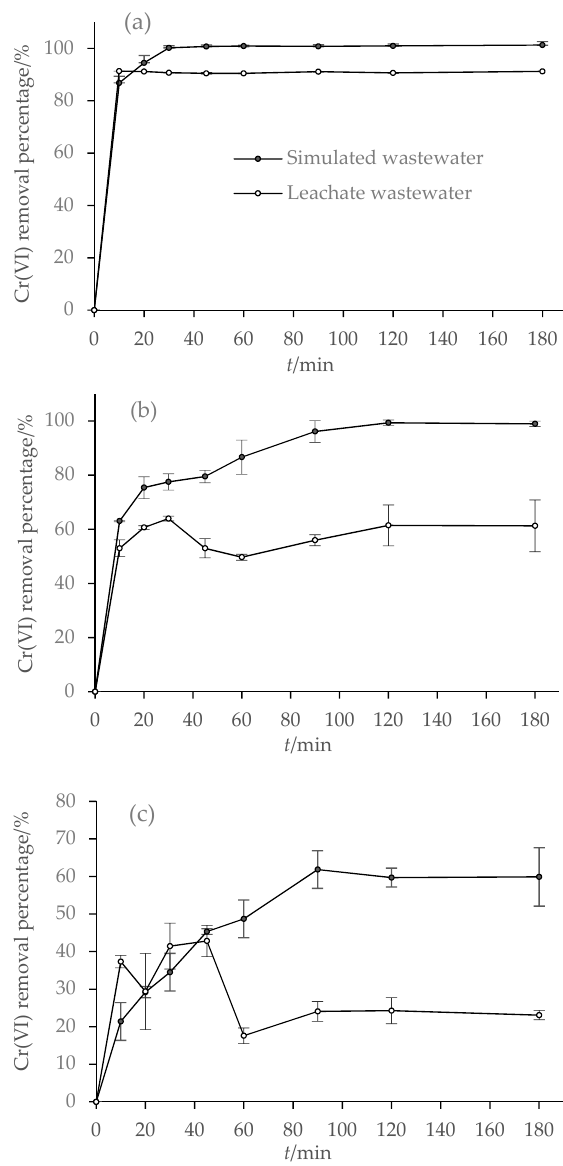
Figure 4. Effect of reaction time on Cr (VI) removal ( n = 3) from wastewaters by BFe 0 NPs (4%) at different pH values: ( a ) pH 2.0; ( b ) pH 2.5; and ( c ) pH 3.0.